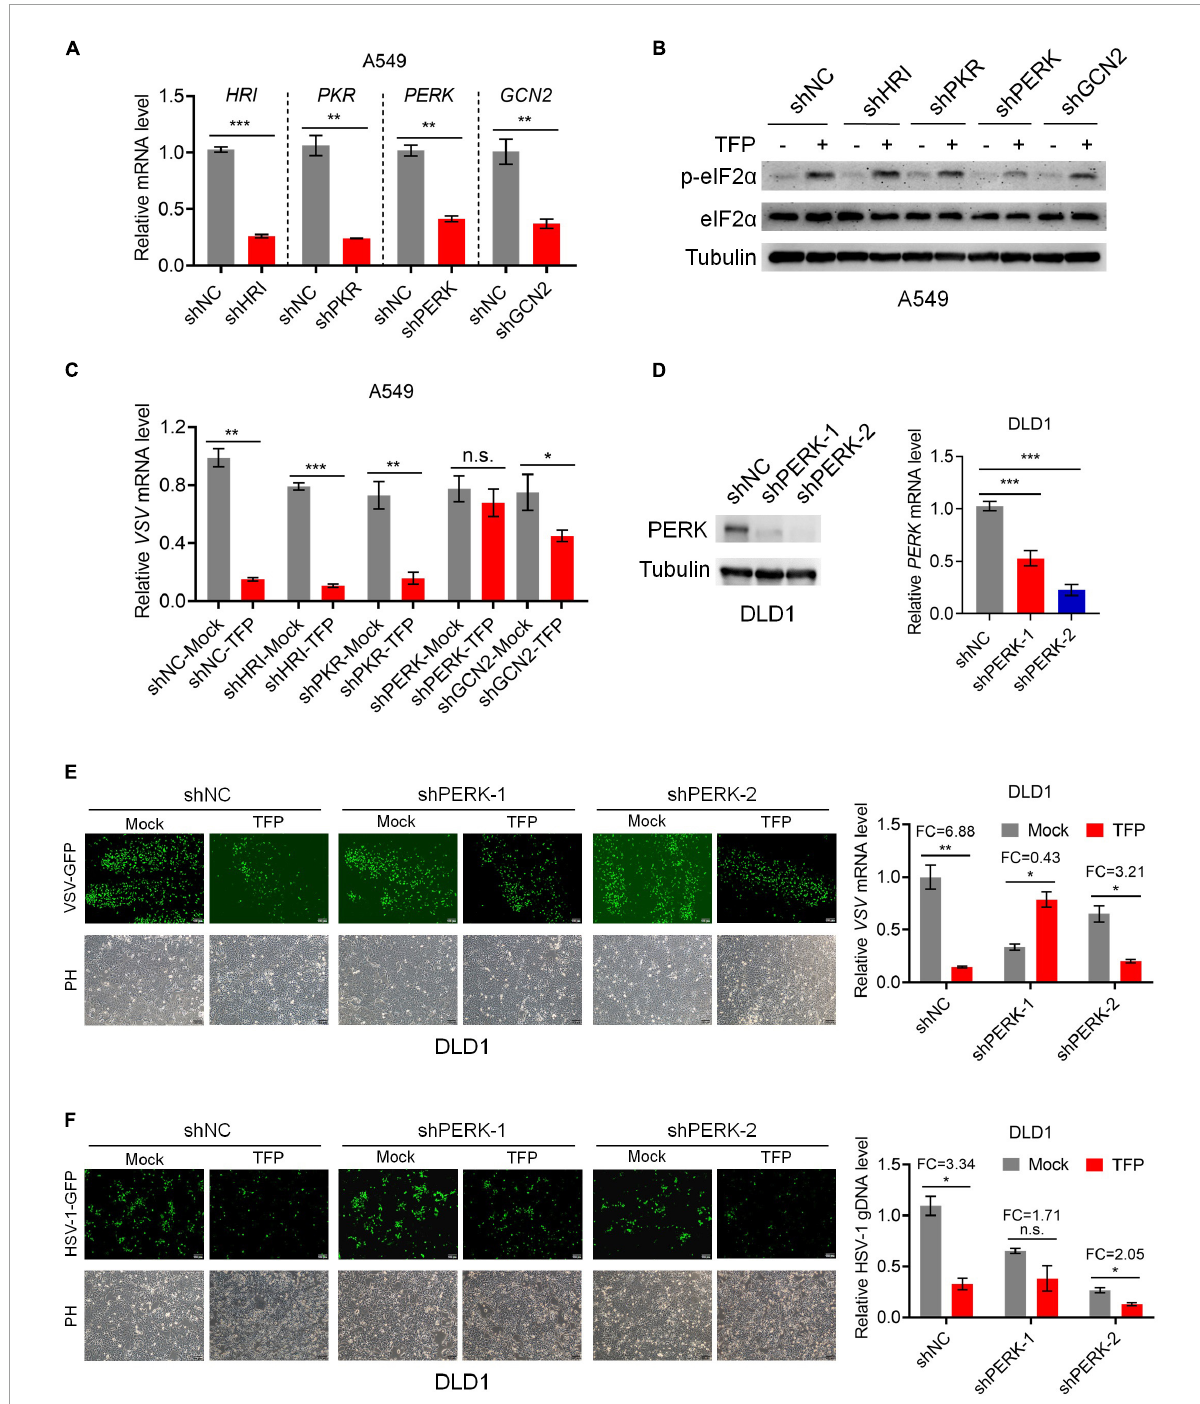
FIGURE4 TFP phosphorylates eIF2 α through activating PERK. (A) qPCR analysis of HRI , PKR , PERK , and GCN2 knockdown efficiency in A549 cells. (B) Immunoblot analysis of P-eIF2 α and eIF2 α levels of shNC, shHRI, shPKR, shPERK, and shGCN2 A549 cells treated with 15 µ M TFP for 12 h. (C) qPCR analysis of VSV mRNA expression in the cells shown in panel (B) . (D) Immunoblot and qPCR analysis of PERK knockdown efficiency in DLD1 cells. (E) shNC, shPERK-1, and shPERK-2 DLD1 cells were treated with 15 µ M TFP for 12 h before infected with VSV-GFP (MOI = 0.1) for another 12 h. Viral replication was detected using fluorescence microscopy and qPCR. (F) shNC, shPERK-1, and shPERK-2 DLD1 cells were treated with 15 µ M TFP for 12 h before infection with HSV-1 (MOI = 10) for 24 h. Viral replication was detected using fluorescence microscopy and qPCR. Scale bars, 100 µ m. ND, not detected. * p < 0.05, ** p < 0.01, *** p < 0.001, n.s., not significant [two-tailed Student’s t -test ( A,C,E,F , right)] or one-way ANOVA with Bonferroni’s post-test ( D , right). Data from three independent experiments [means ± SDs of triplicate assays ( A,C,D–F , right)] or representative data from three independent experiments with similar results ( B,D–F , left) are